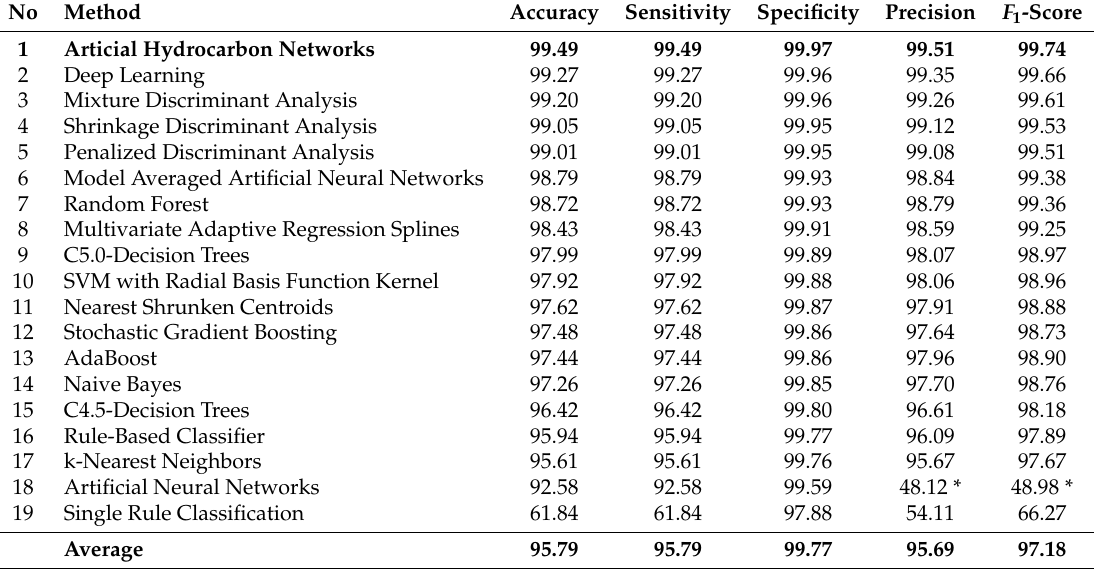
Table 9. Results of case 3: Cross-validation within a subject overall performance for the user-dependent approach. Values with (*) were obtained using only available metrics when they can be performed over